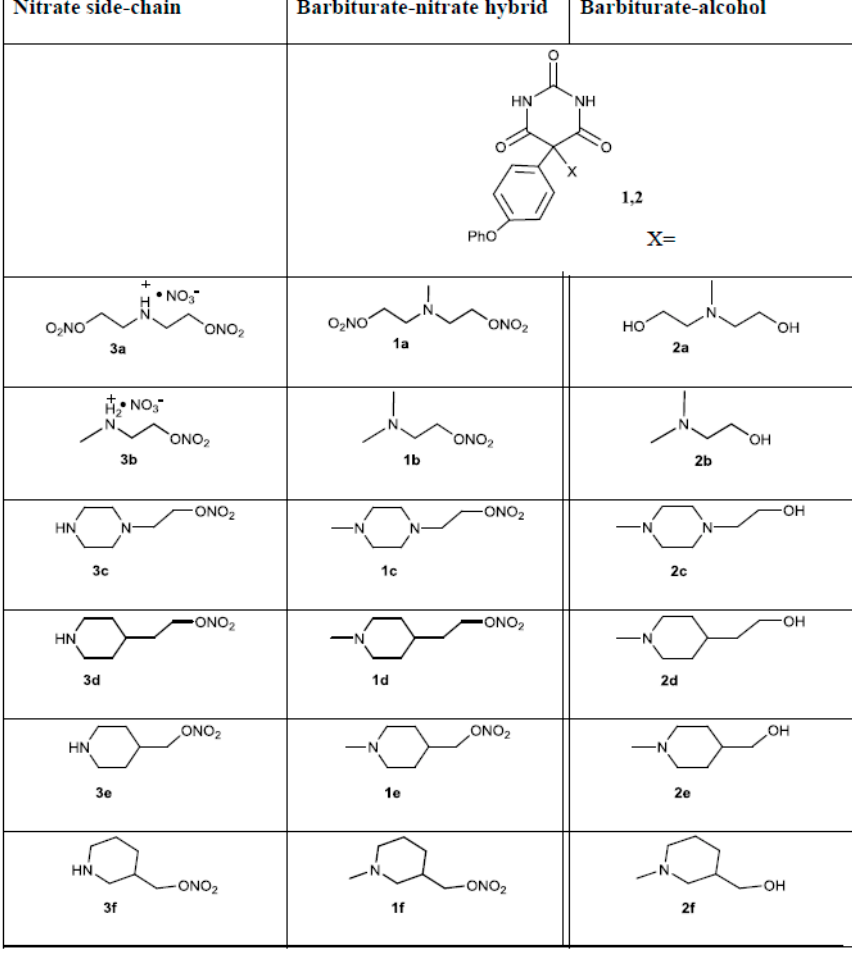
Figure 1. Structures of compounds used. Column one shows the nitrate side-chains. Columns two and three show the barbiturate scaffold and the nitrate and alcohol side-chains, respectively. The nitrate-barbiturates (10 µ M) caused a statistically significant reduction in MMP-9 mRNA in cytokine-stimulated Caco-2 cells after 24 h compared to the untreated, stimulated cells (Figure 2). Compounds 1c and 1a caused the greatest mean inhibition. The alcohol-barbiturates also inhibited the transcription of MMP-9 at 10 µ M but to a lesser extent. The nitrate side-chains did reduce MMP-9 expression when tested at 10 µ M (Figure 2), but this inhibition did not reach statistical significance except for compound 3f . The compounds in parallel experiments did not a ff ect mRNA levels of MMP-1 or MMP-2, showing selectivity for inhibition of MMP-9.